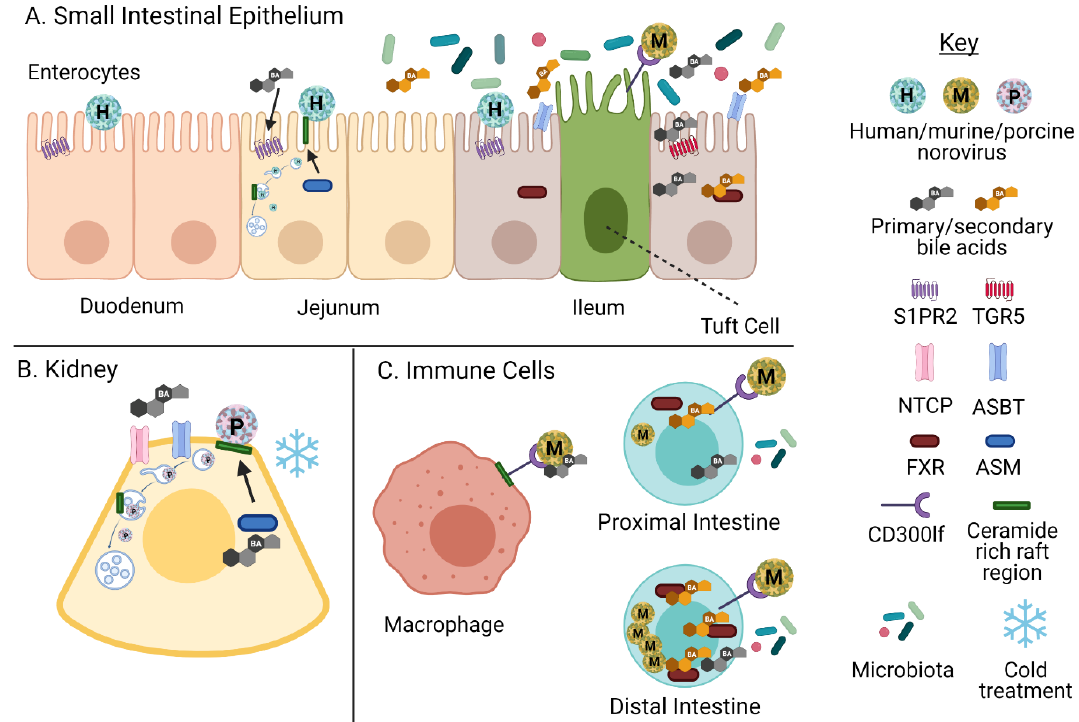
Figure 5. Models for bile acid-mediated infection by noroviruses in different cell types. ( A ) Bile-dependent and -independent human noroviruses infect duodenal, jejunal, and ileal HIEs. The mechanism of GII.3 BA mediated infection in HIEs is well characterized in jejunal HIEs [1]. MNV infects tuft cells of the mouse ileum [54]. ( B ) PoSaV infects porcine kidney cells in a BA-dependent manner described below. ( C ) MNV infects immune cells (right) [55,56]. BAs influence replication of MNV in different regions of the intestine (left). Adapted by permission from Springer Nature: Springer Nature, Nature Microbiology, from ref. [4], copyright (2019). Created with BioRender.com, accessed on 12 March 2021.